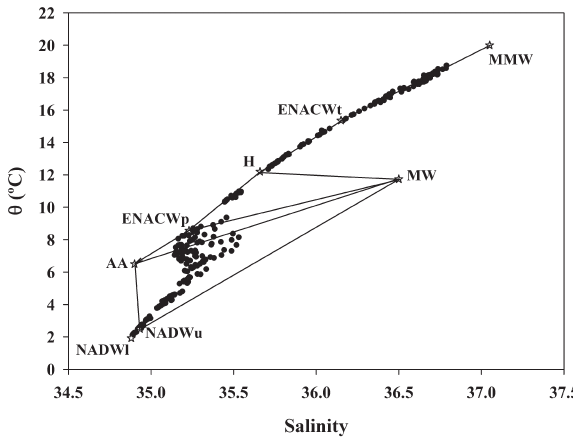
Fig . 6. – θ -S diagram using the bottle data, the thermohaline proper- ties of the different water types indicated as starts and the applied mixing triangles used in the mixing model. Madeira Mode Water (MMW), subpolar East North Atlantic Central Waters (pENACW) and subtropical East North Atlantic Central Waters (tENACW), H end-member, Mediterranean waters (MM), Diluted Antarctic Water (AA) and North Atlantic Deep Water divided into upper and lower limits, uNADW and lNADW, were considered. ESTOC data were resolved by replacing the AA point with